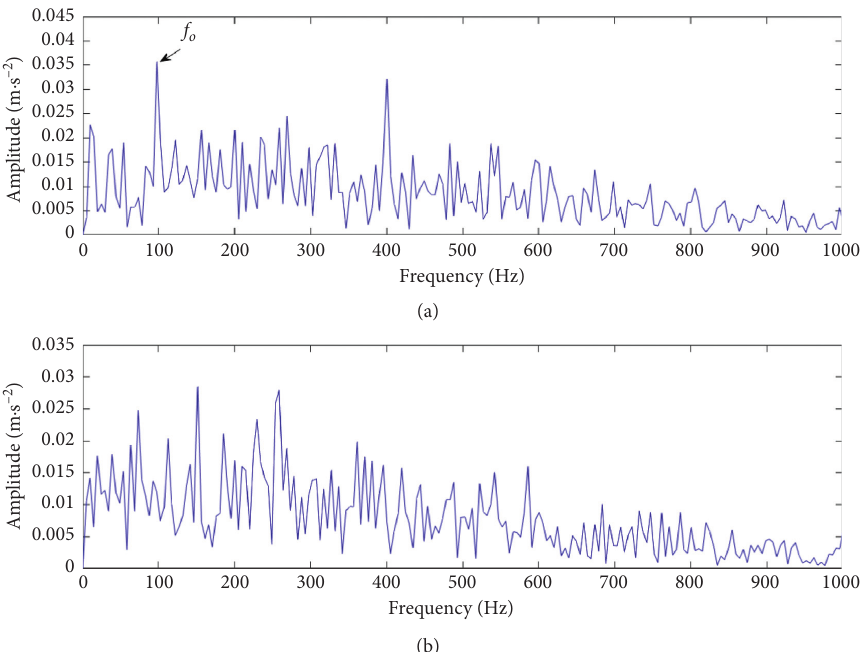
Figure 7: Analysis results of randomly selected parameter combinations. (a) Combination of parameters [10, 400]. (b) Combination of parameters [5,